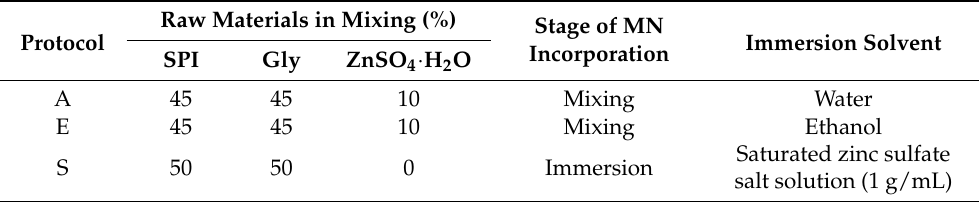
Table 2. Raw materials, micronutrient (MN) incorporation and immersion solvent of the different protocols used to produce matrices with zinc